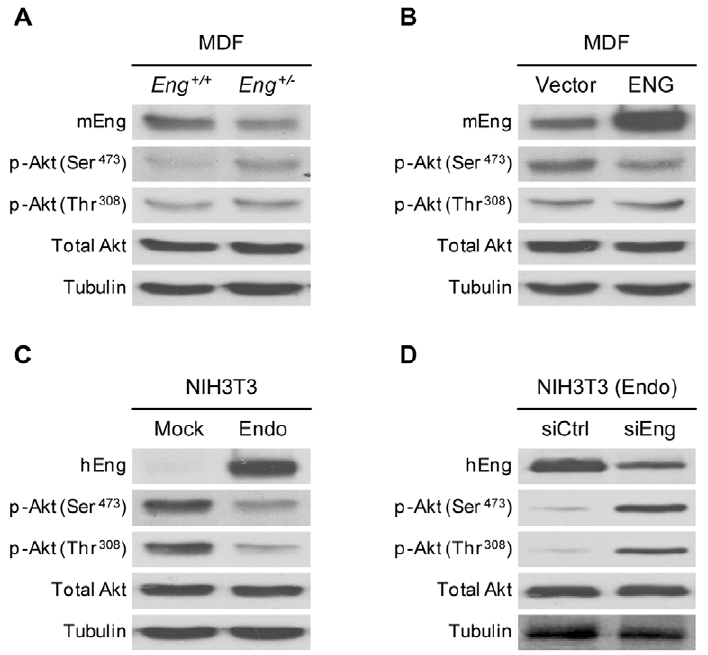
Figure 7. Effect of endoglin expression on Akt phosphorylation. ( A ) Ser 473 and Thr 308 Akt phosphorilation and Akt expression were analyzed by western blot in total protein extracts from Eng + / + and Eng + / 2 MDF. ( B – D ) Similar analysis were carried on in Eng + / 2 MDF transiently transfected with ENG or empty vector ( B ); NIH3T3 overexpressing by retroviral infection endoglin (Endo) and its controls (Mock) ( C ); and Endo fibroblasts transfected with anti-Eng siRNA ( D ). Tubulin was used as loading control. A representative blot from three independent experiments is